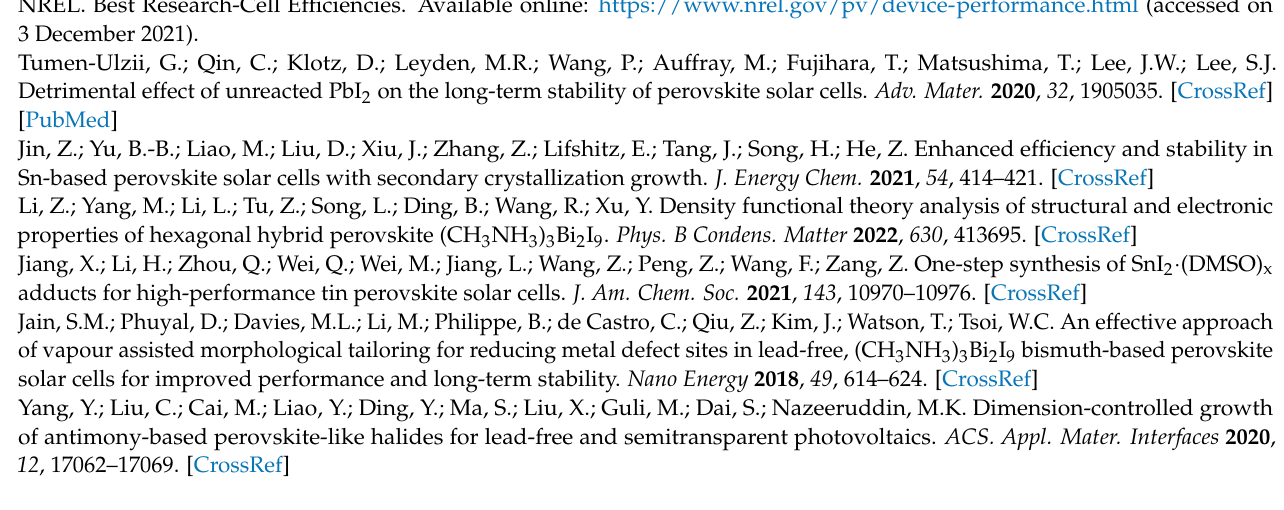
element distribution maps of Cs, Sb, I, Cl, and S; Figure S4. XRD diffraction patterns of (a) the control and (b) 0.2 M TU additive Cs 3 Sb 2 I 9 − x Cl x films under different SbI 3 vapor annealing time. The annealing time was assigned 0, 3, 5, 10, and 15 min, respectively. The “*” symbols represent the signals of the TiO 2 /FTO substrates; Figure S5. FTIR spectra of TU, CsI · SbI 3 · SbCl 3 · TU before SbI 3 vapour annealing, and CsI · SbI 3 · SbCl 3 · TU after SbI 3 vapour annealing; Figure S6. (a) XPS survey spectra of the 0.2 M TU additive Cs 3 Sb 2 I 9 − x Cl x films before and after SbI 3 vapour annealing; Figure S7. (a,b) XPS results of the core-level peak for N 1s and S 2p were obtained from the 0.2 M TU additive Cs 3 Sb 2 I 9 − x Cl x films under different SbI 3 vapor annealing times; Figure S8. (a) UV-visible and (b) Tauc plots of Cs 3 Sb 2 I 9 − x Cl x thin films with different amounts of TU additive; Figure S9. Schematic of the band energy diagrams for the control, 0.1 M, 0.2 M and 0.3 M TU additive Cs 3 Sb 2 I 9 − x Cl x PSCs; Figure S10. (a,b) Cross-sectional image of the control and 0.2 M TU additive Cs 3 Sb 2 I 9 − x Cl x films; Figure S11. (a–d) Comparison of histograms of photovoltaic parameters for the perovskite solar cells based on control and 0.2M TU additive condition. (Data from 20 cells were used for the histogram); Table S1: XRD parameters of FWHM, crystallite size (D = 0.9 λ / β cos θ ), dislocation densities ( δ = n/D 2 , n is a factor which is almost equal to unity for minimum dislocation density), and lattice constants for the control and different amounts of TU Cs 3 Sb 2 I 9 − x Cl x films; Table S2. Intensity ratios of (201)/(003) planes of Cs 3 Sb 2 I 9 − x Cl x films with different amounts of TU; Table S3. TRPL decay parameters for the control and 0.2 M TU additive Cs 3 Sb 2 I 9 − x Cl x films; Table S4. The electron trap density of Cs 3 Sb 2 I 9 − x Cl x films with different amounts of TU additive; Table S5. Photovoltaic parameters of the perovskite solar cells fabricated with different amounts of TU additive; Table S6. A summary of the device performance of Cs 3 Sb 2 I 9 − x Cl x solar cells; Table S7 Parameters fitted from electrochemical impedance spectra of the device based on Cs 3 Sb 2 I 9 − x Cl x films with different amounts of TU